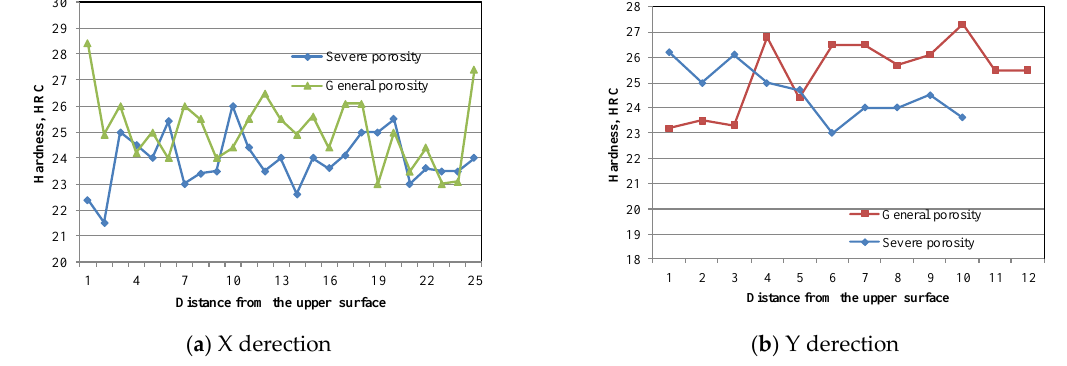
Figure 3. Hardness distribution of normal and defective specimens in different directions.